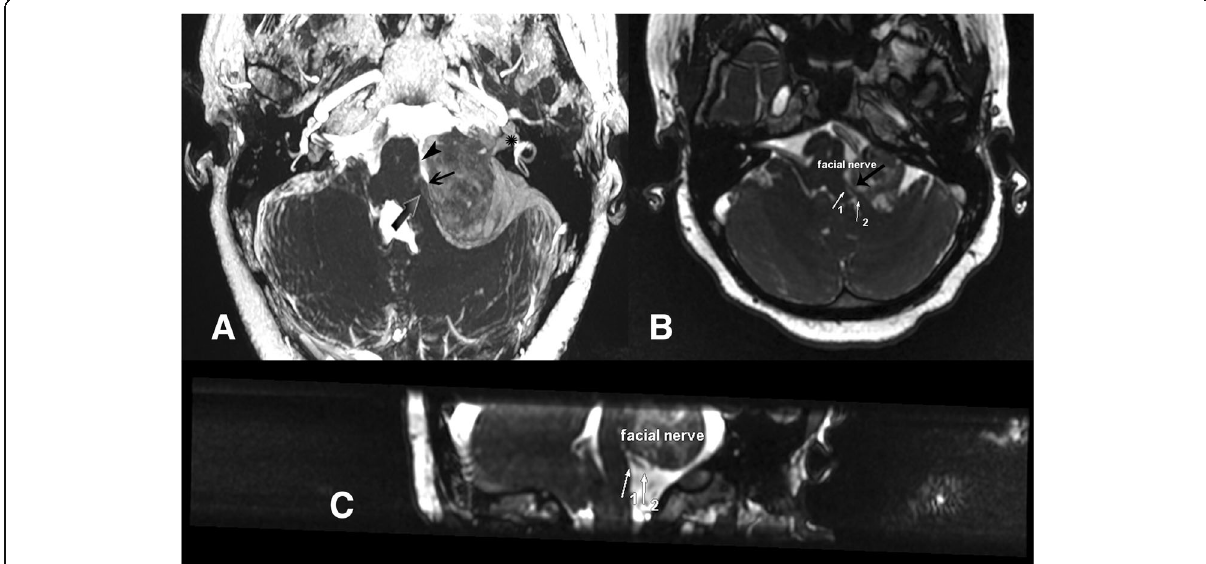
Fig. 1 FIESTA study showing the posterior location of the facial nerve. a Axial image where the arrowhead points to the CSF signal between the medial surface of the tumor and the brainstem. Arrows point to the nerve and its posterior direction. b Axial image for another patient where white and black arrows point to the nerve and its direction. c Coronal reconstruction showing the posteroinferior location. The other side showing the cerebellar